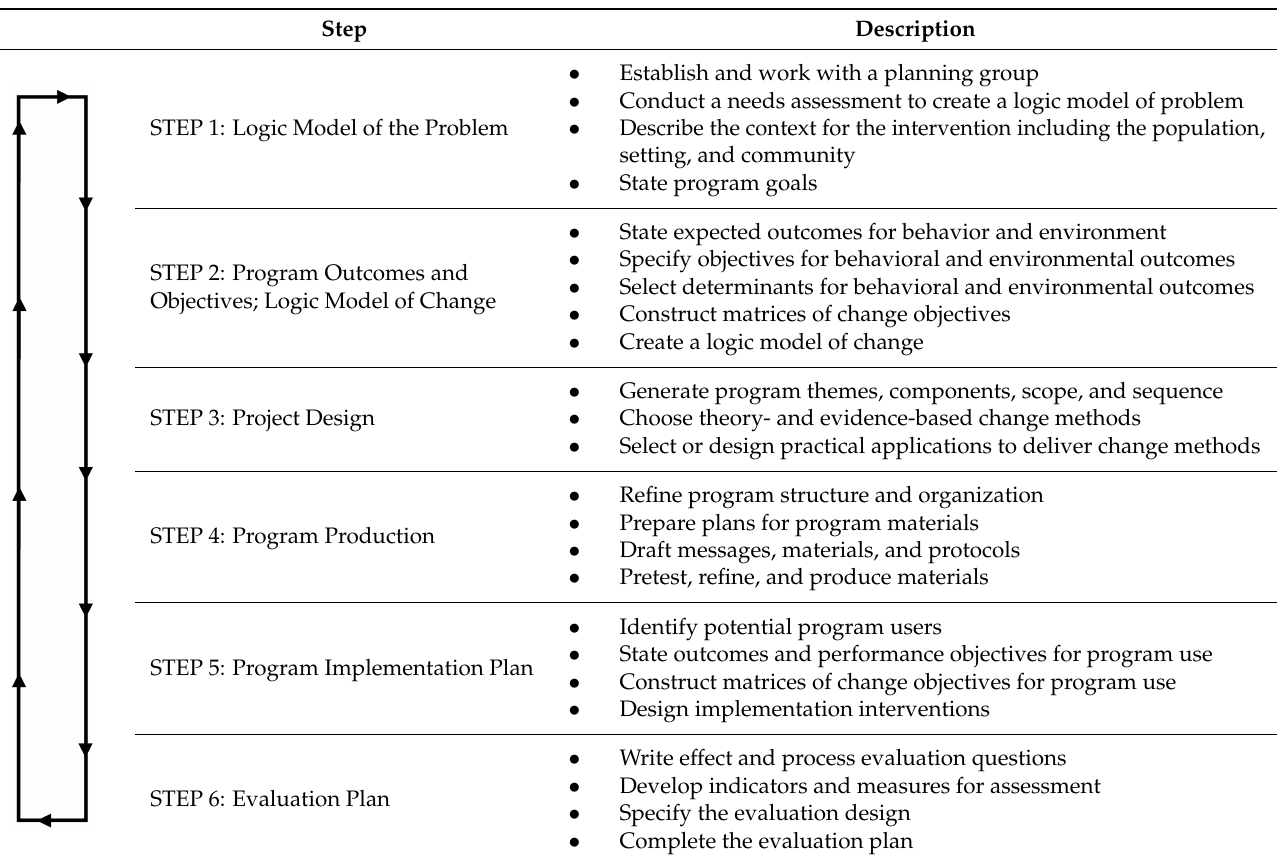
Table 1. Intervention mapping approach ([23],